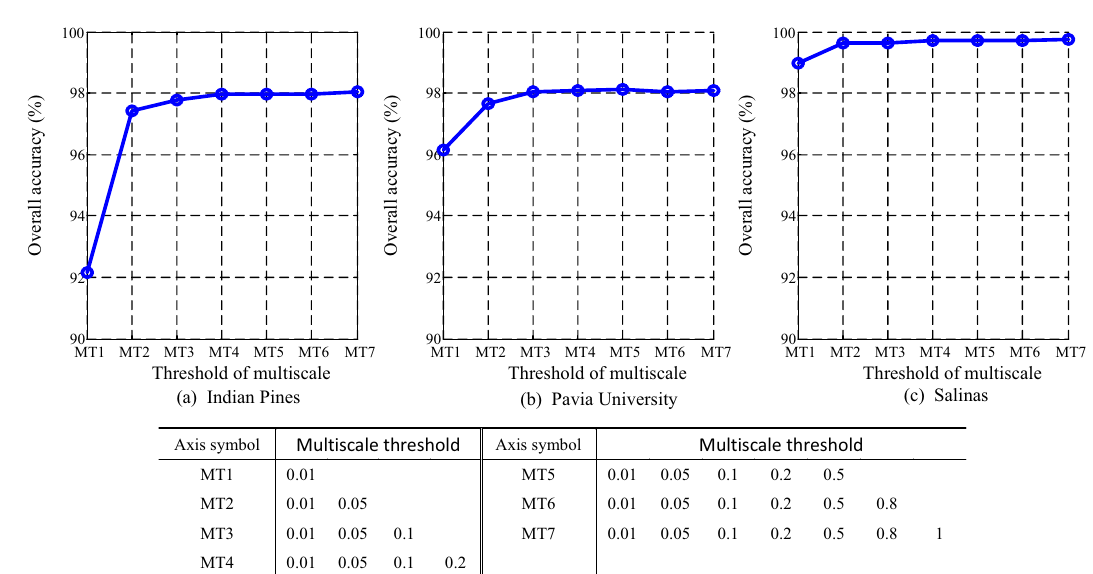
Figure 9. Overall accuracy of multiscale low rank